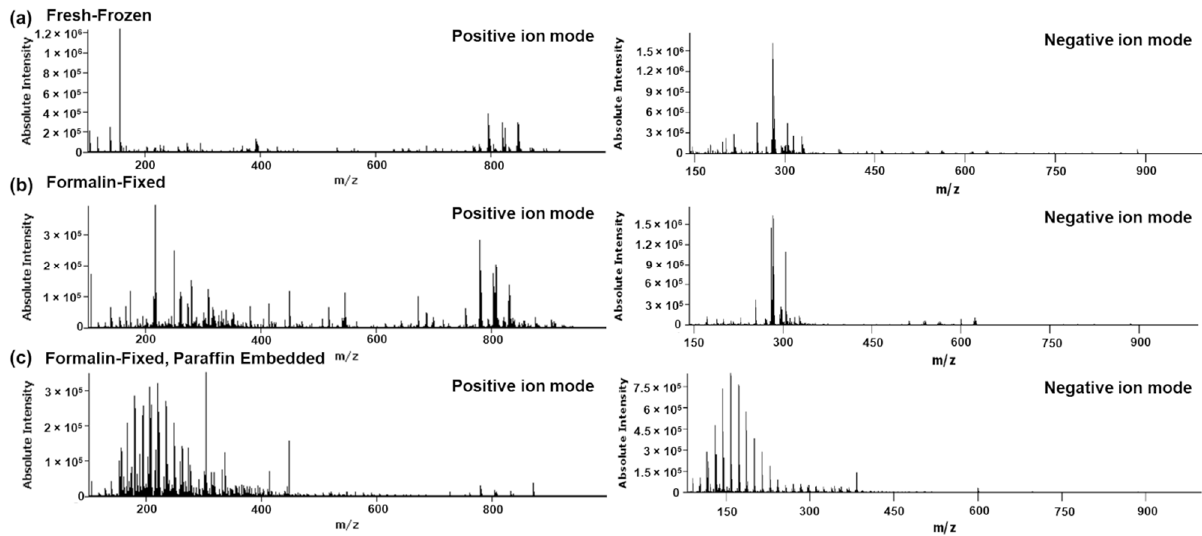
Figure 1. Representative mean spectra of ( a ) fresh-frozen, ( b ) formalin-fixed and ( c ) formalin-fixed, paraffin embedded rat liver specimens analyzed by DESI-MSI in positive and negative ion mode, respectively. All tissues were collected from the same